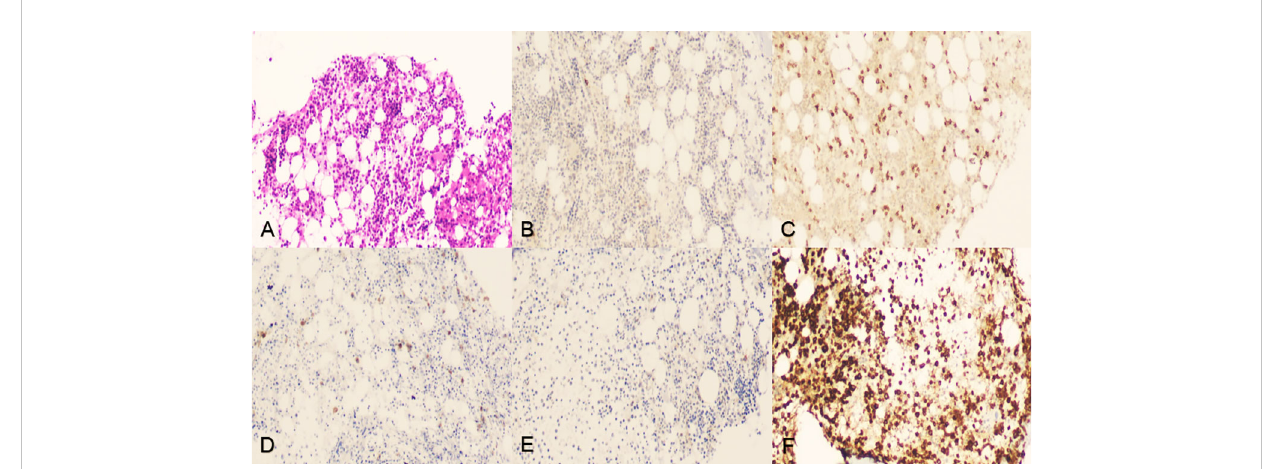
FIGURE 3 Iliac crest bone marrow aspiration and biopsy. (A) Tissue section indicated neither lymphocytic in fi ltration nor myelodysplastic disorder but showed abnormal immunohistochemistry, hematoxylin – eosin staining, original magni fi cation ×100. (B-D) Tumor cells were positive for CD20, CD3, and CD79 a , original magni fi cation ×100. (E) Tumor cells were negative for BCL-6, original magni fi cation ×100. (F) Tumor cells were positive for MPO activity, 3,3 ’ -diaminobenzidine staining, original magni fi cation